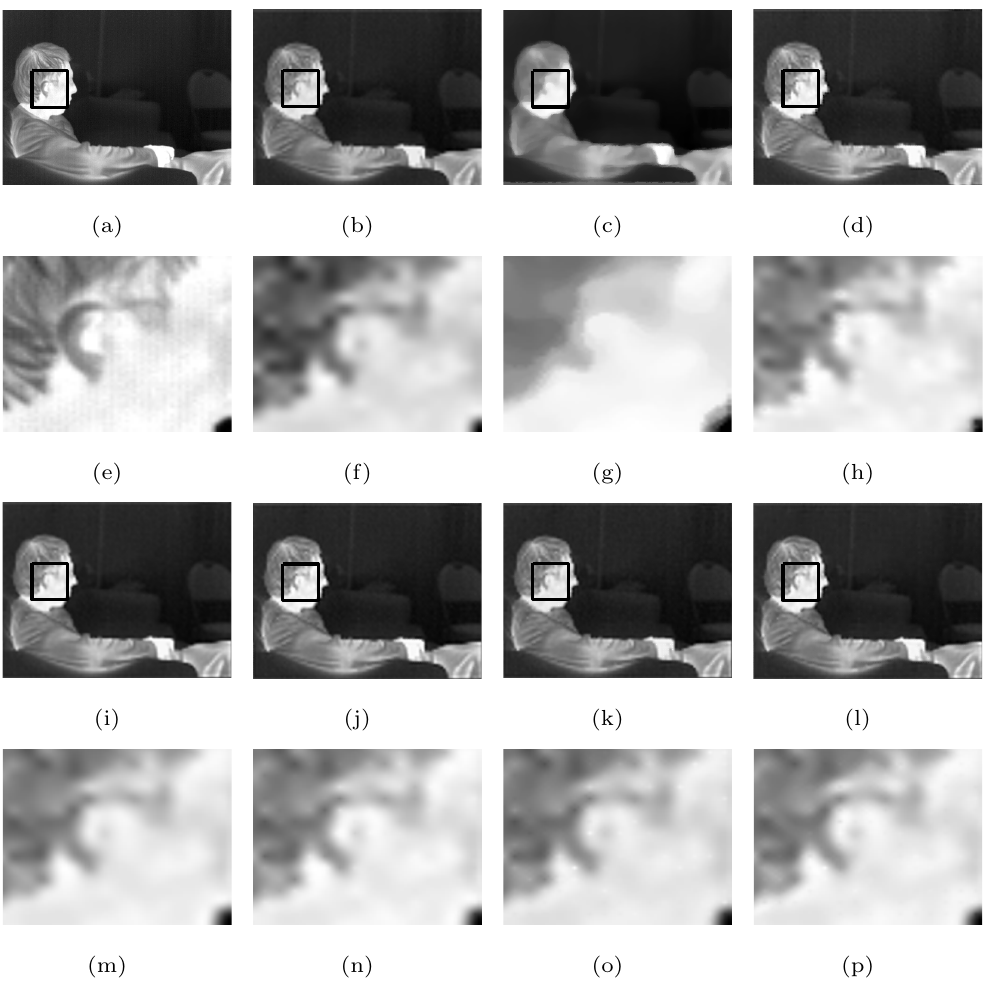
图 1: description of figure Figure 7. Super-resolution x4 results of the LR figure images without noise; ( a – d , i – l ) ground truth